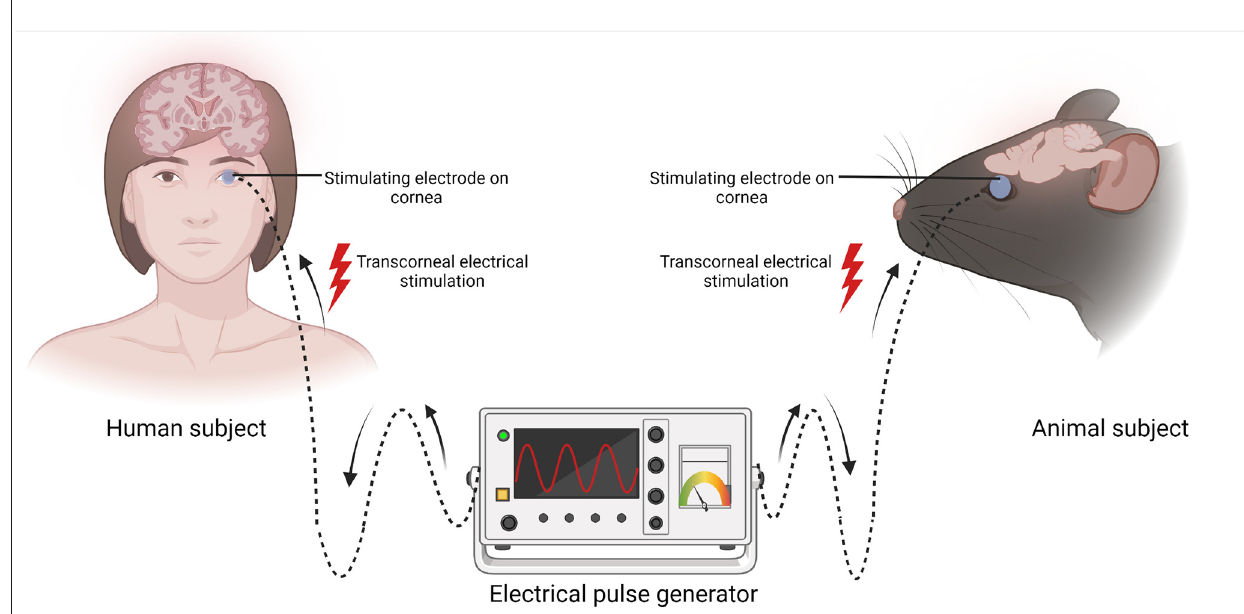
FIGURE1 Schematic representation of transcorneal electrical stimulation (TES). In both human and animal subjects, the stimulating electrode (blue circle) is positioned on the cornea and the other end is connected to an electrical pulse generator (EPG). Electric current pulses activate the retina and its downstream structures. Created with BioRender.com (accessed December 13,